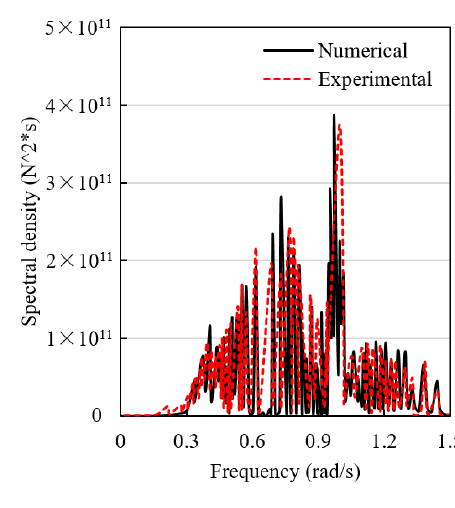
Figure 8. Pitch motion of the CALM buoy.